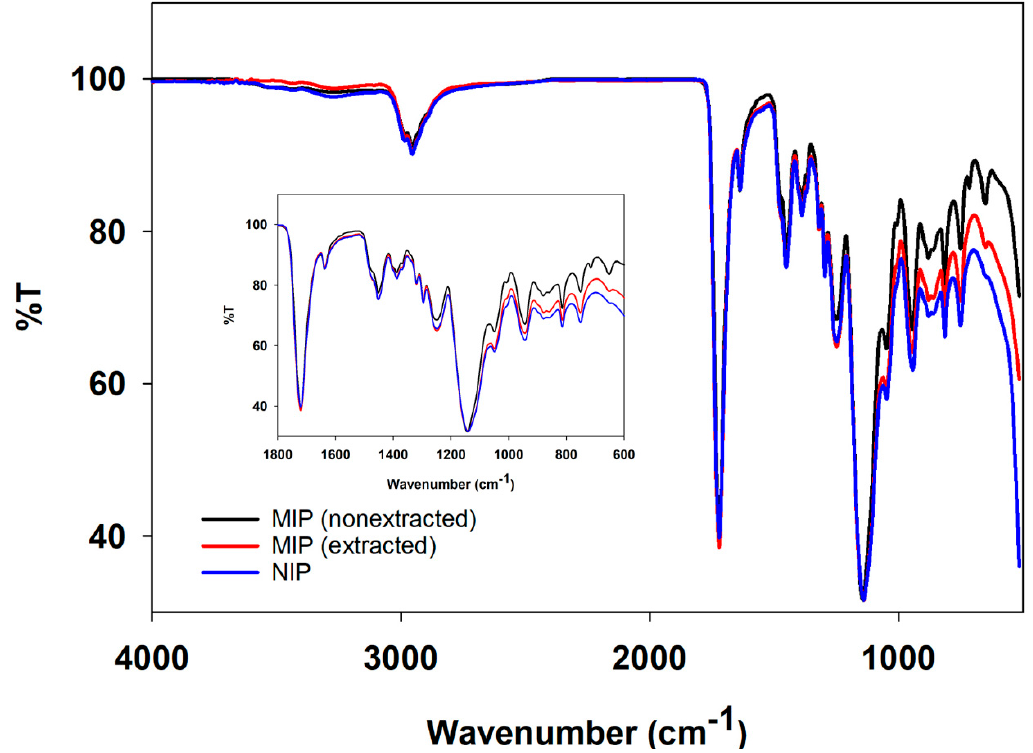
Figure 3. Infrared spectra of synthesized polymers. Red line represents MIP (non-extracted), blue line represents MIP (extracted), and black line represents NIP.